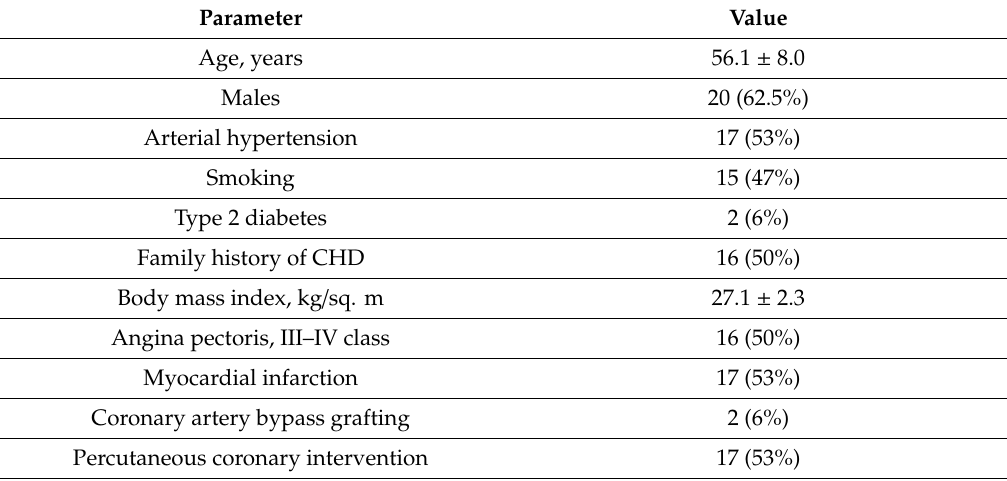
Table 1. Characteristics of 32 study